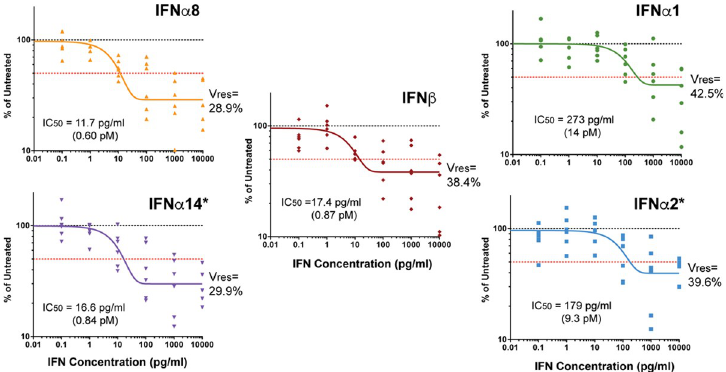
Fig 1. HIV-1 inhibition curve of IFN β . LPMCs (n = 6 donors) were infected with HIV-1 BaL then resuspended with various doses of IFN-Is. After 4 d, the frequencies of HIV-1 p24+ cells were evaluated on CD3+CD8- cells via flow cytometry. Data were normalized to mock (untreated) as 100% for each donor. Dose-response curves were generated using a one-phase decay equation in GraphPad Prism 5.0 to determine IC50 values. Vres, the percentage of cells that remain infected relative to the mock at the maximum dose tested, corresponded to plateau values from the decay equation. � Note that data on IFN α 14 and IFN α 2 were previously published [13].